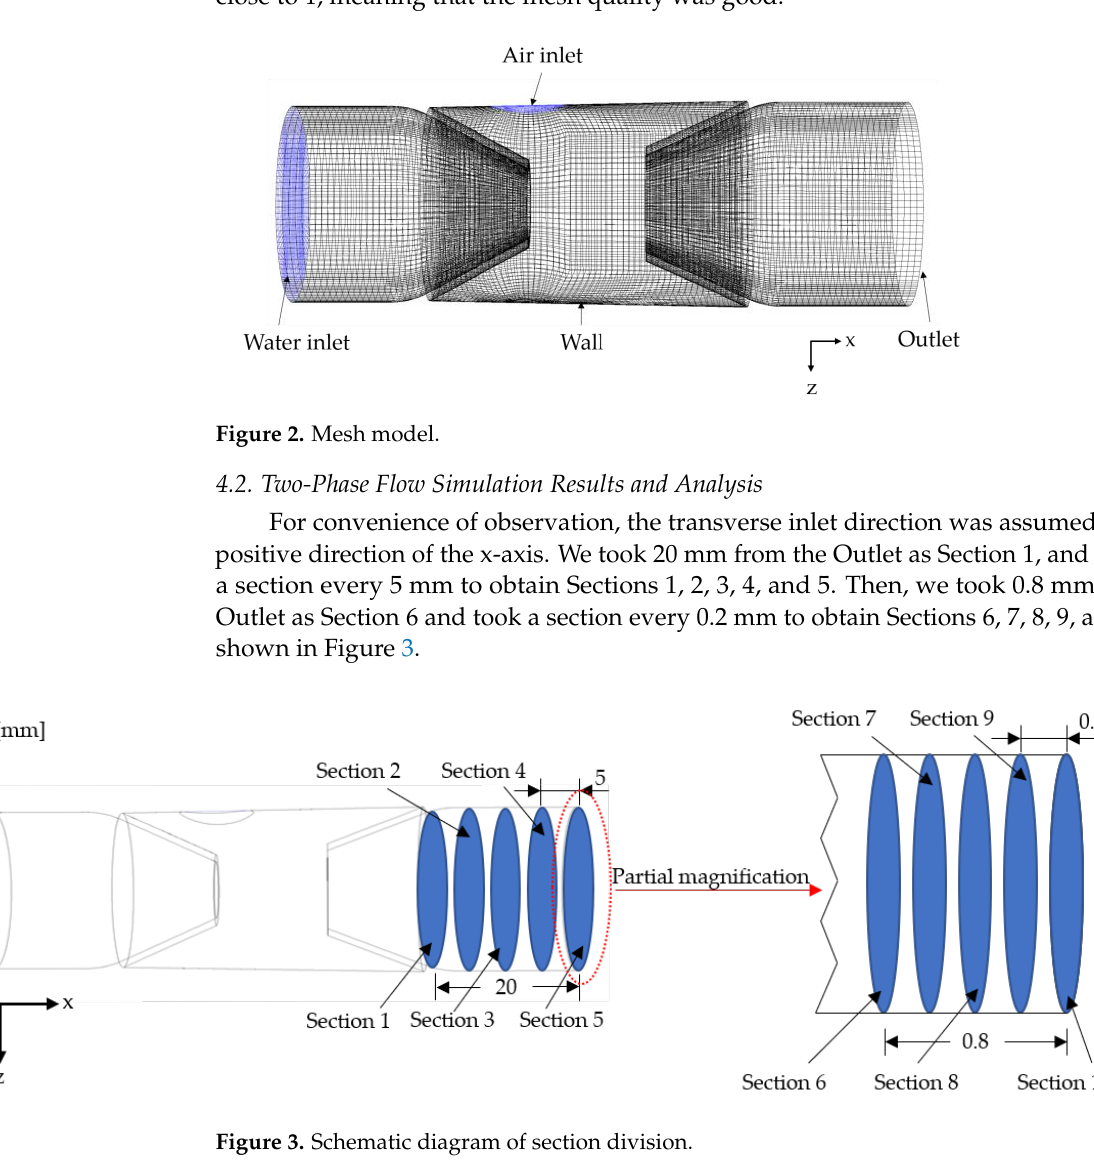
Figure 4. Cloud map of gas-phase distribution at an ( a ) inlet flow velocity 6.5 m/s and ( b ) inlet flow velocity 7.5 m/s. Five sections were selected at the lateral center of Sections 6 – 10, which were Line 6, Line 7, Line 8, Line 9, and Line 10. Figure 5a,b show that the gas accumulated more at both ends and was lower near the wall. A certain amount of gas was also observed in the center due to the jet. When the inlet flow rate was 6.5 m/s, the gas content near the wall was higher than when the inlet flow rate was 7.5 m/s. Moreover, at an inlet flow rate of 7.5 m/s, the gas content at the center of the pipe was higher than that at an inlet flow rate of 6.5 m/s. This was because the flow velocity at the center increased along with the inlet flow rate, which pulled in more air bubbles moving in flow in the center.